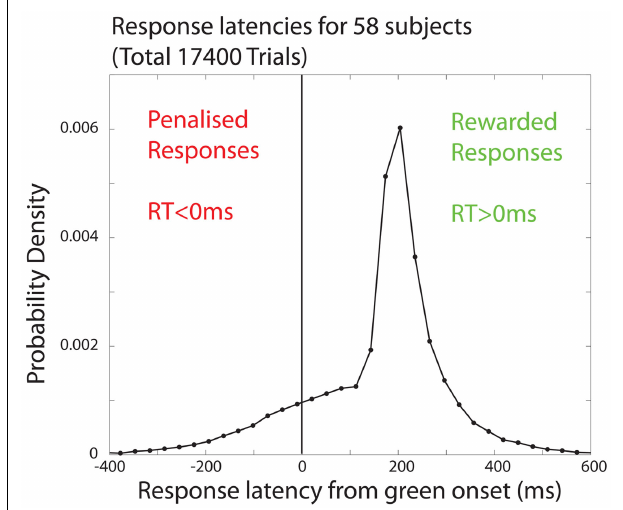
FIGURE 3 | Response time distribution in theTraffic Light task ( N = 58). RT data, pooled across participants, shown with respect to green onset at t =